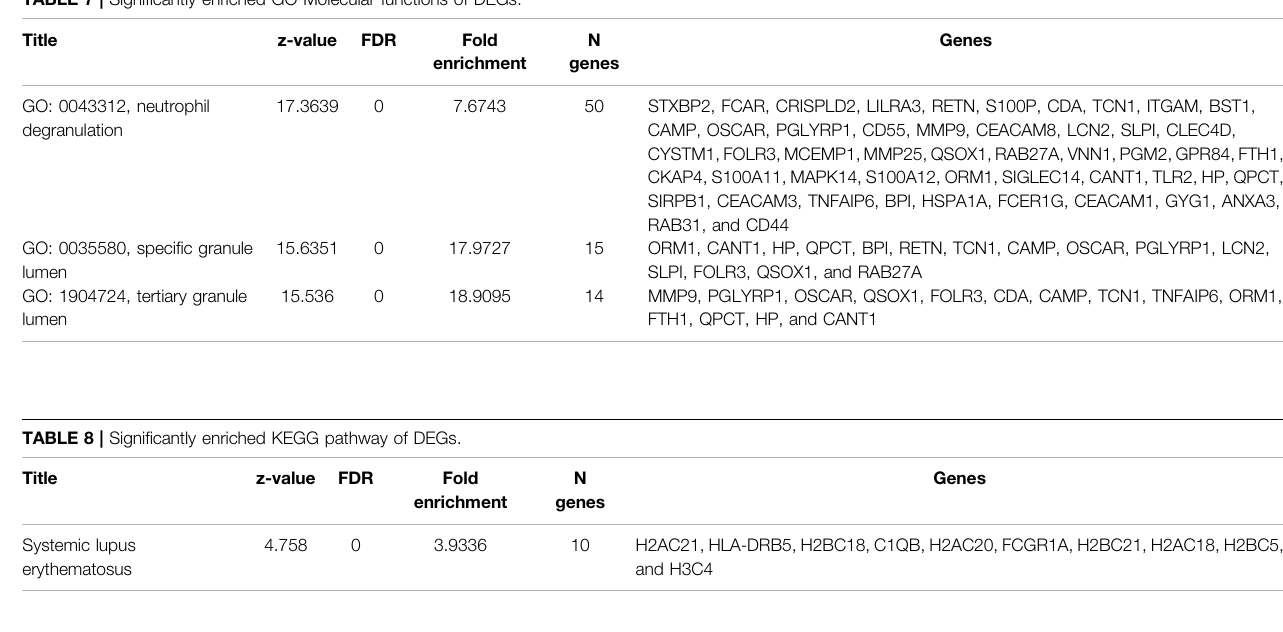
TABLE 7 | Signi fi cantly enriched GO Molecular functions of DEGs.